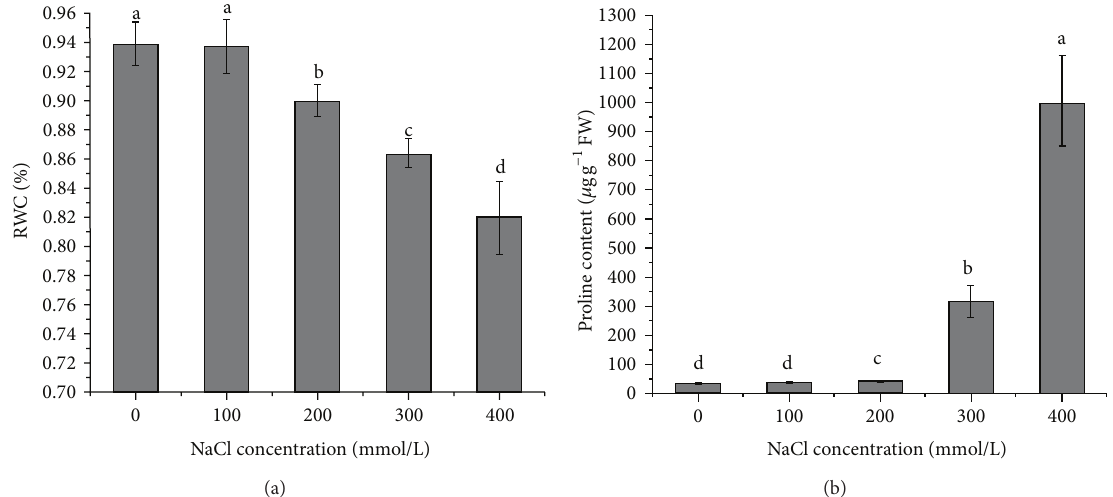
Figure 3: Changes of relative water content (RWC, (a)) and proline content (b) in seedlings exposed to different NaCl concentrations.